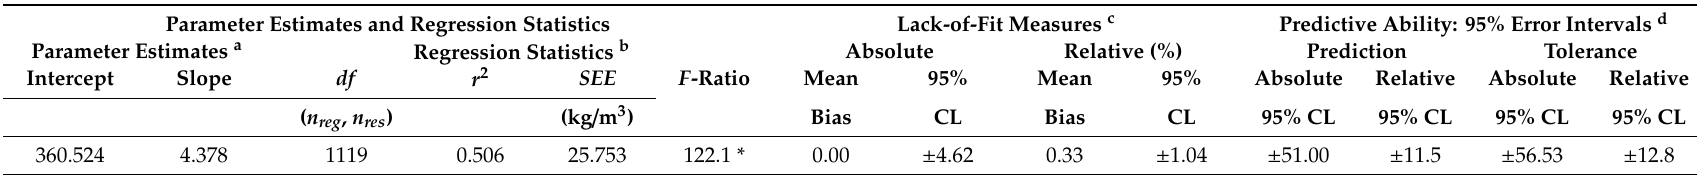
Table 6. Parameter estimates, regression statistics, and predictive bias intervals for the relationship between mean amplitude and wood